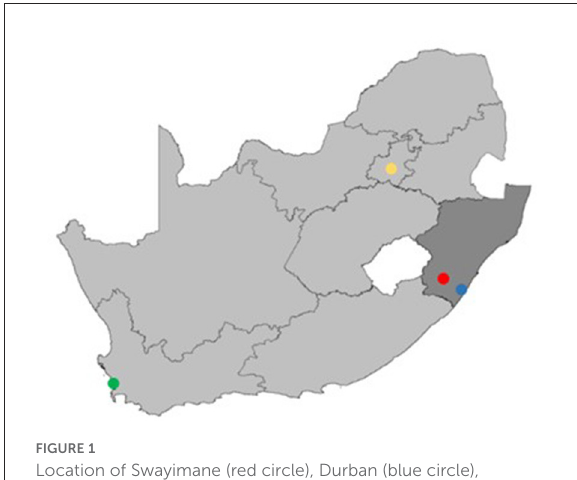
FIGURE1 Location of Swayimane (red circle), Durban (blue circle), Johannesburg (yellow circle), Cape Town (green circle) in South Africa. The dark gray boundary indicates the province of